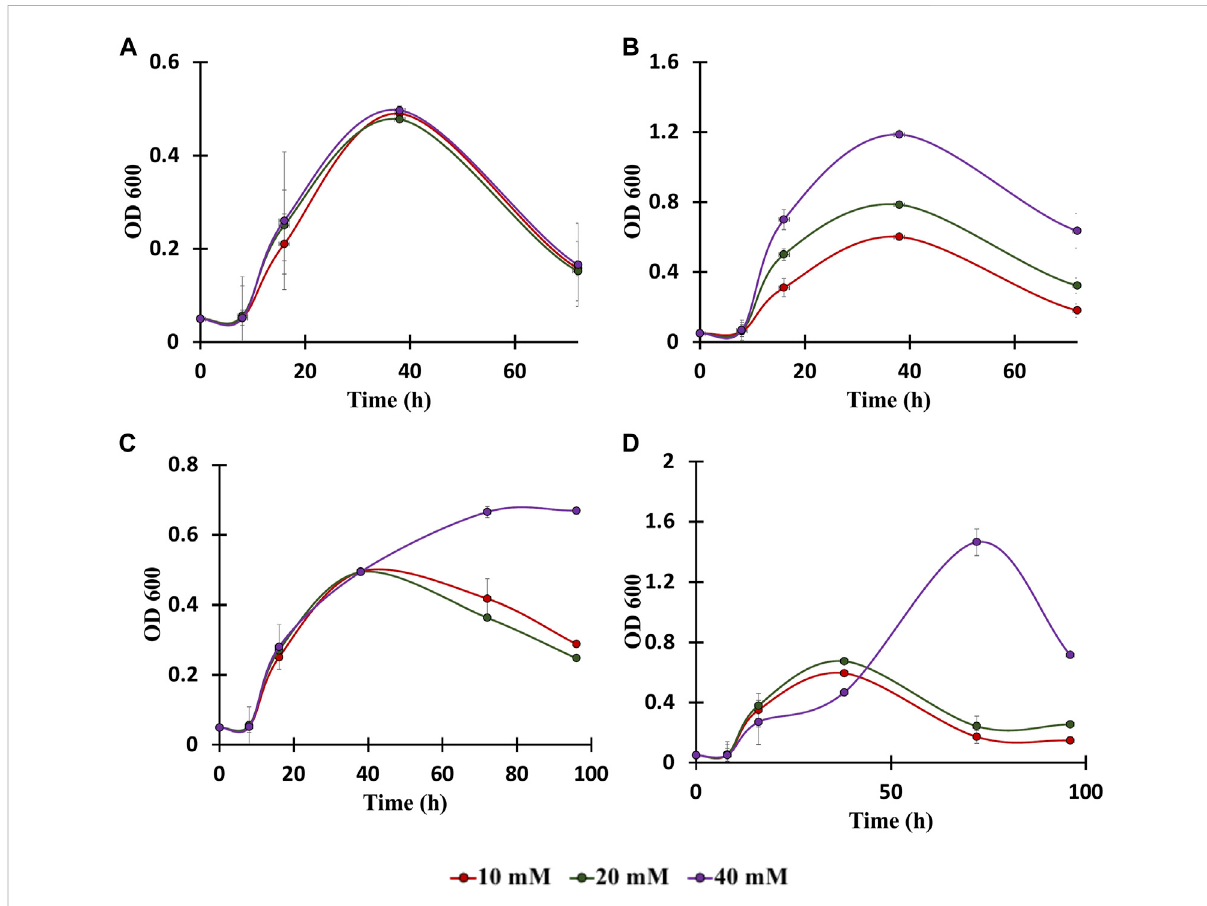
FIGURE 4 Growthassaysof C.glutamicum in: (A) vanillicacid(10,20,40 mM), (B) Benzoicacid(10,20,40 mM), (C) Cinnamicacid(10,20,40 mM),and (D) p-coumaric acid (10, 20, 40 mM). The experiments were performed in biological triplicates. Data represents mean ± SD, n =